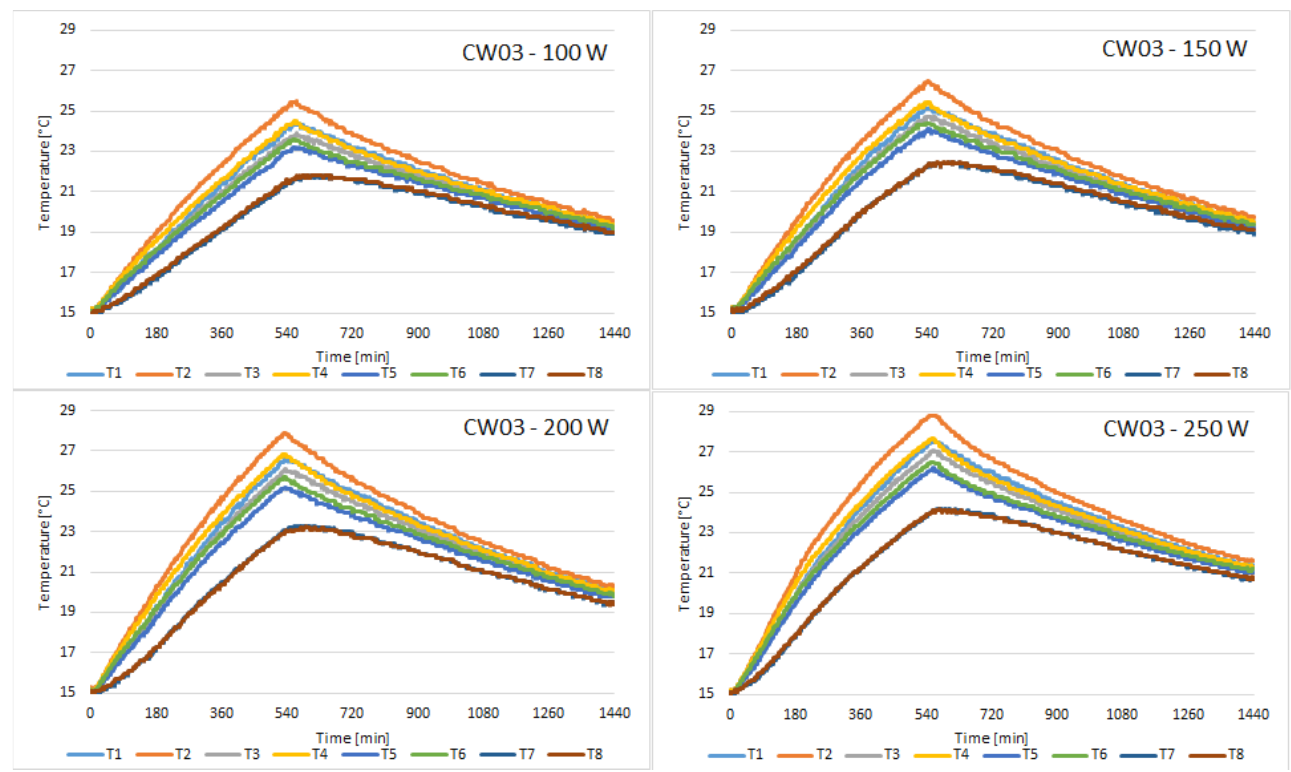
Figure 6. Temperature variation recorded by the sensors for concrete sample CW03.